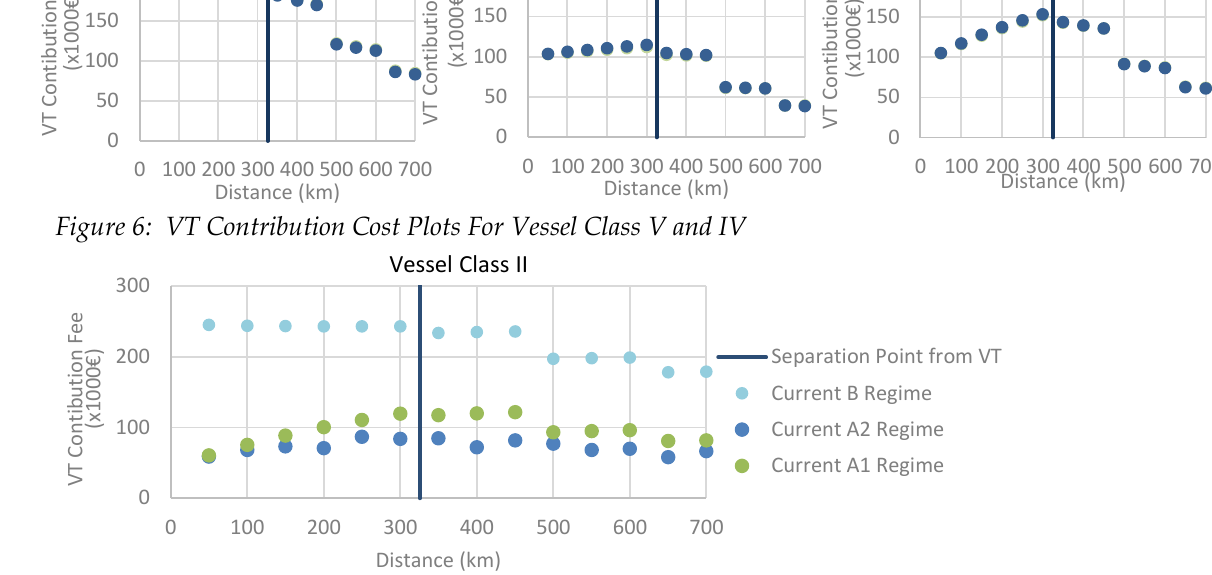
Figure 7: VT Contribution Cost Plots For Vessel Class